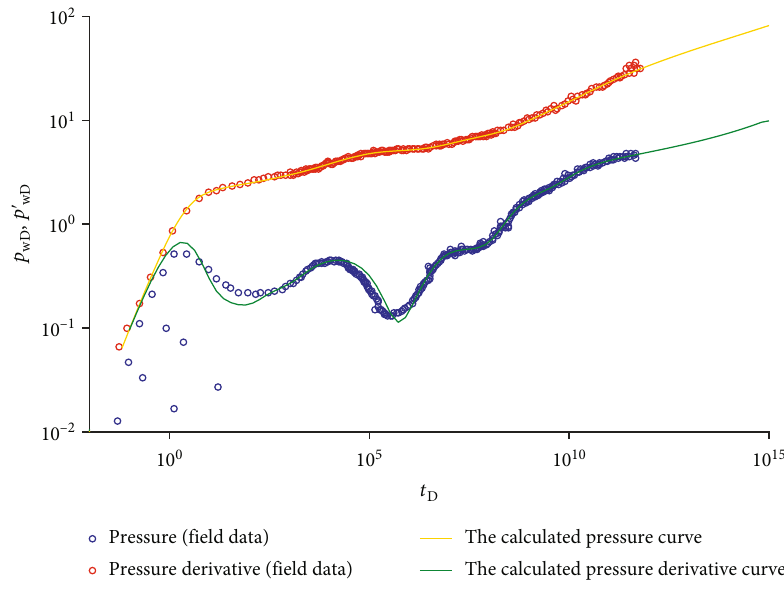
Figure 12: Pressure matching Table 1: The basic parameters for the investigated reservoir.